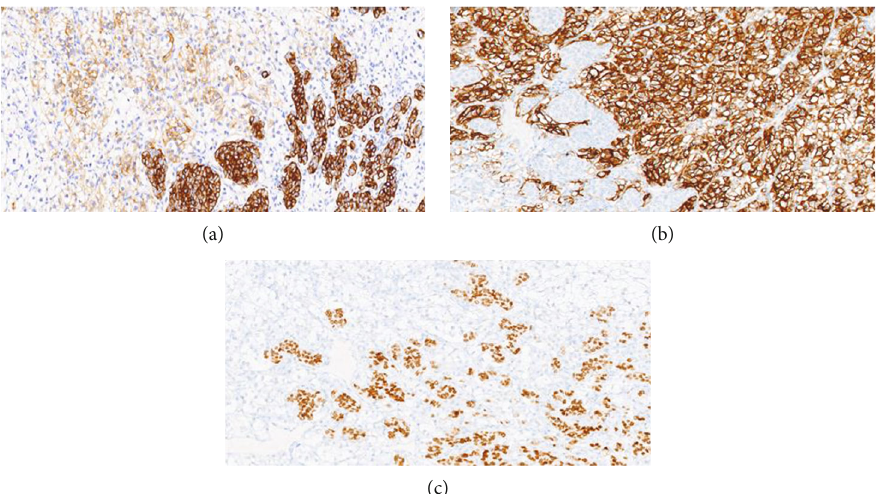
Figure 5: Immunohistochemical stains. (a) (Cam5.2, 200x) Both neoplasms are positive for cytokeratins, con fi rming an epithelial origin of the two neoplastic populations. (b) (CD10, 200x) Strong and di ff use positivity for CD10, characteristic of ccRCC. Highlight the antibody ’ s negativity in the breast carcinoma cell population. (c) (ER, 200x) Strong and nuclear positivity for the antibody directed to ER in breast carcinoma cells. Highlight the antibody ’ s negativity in the ccRCC component.